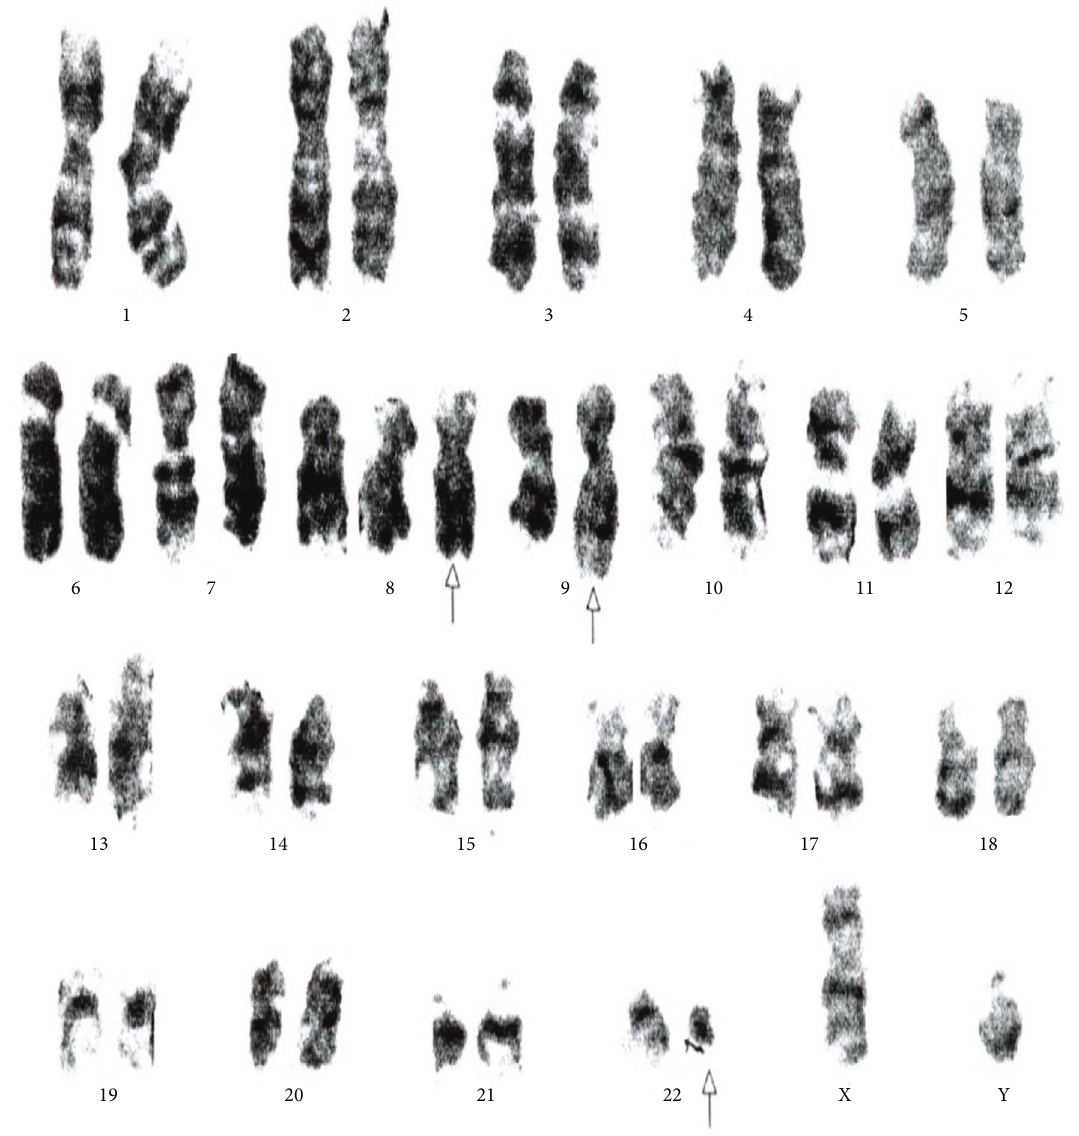
Figure 7: Cytogenetic analysis shows a rare translocation